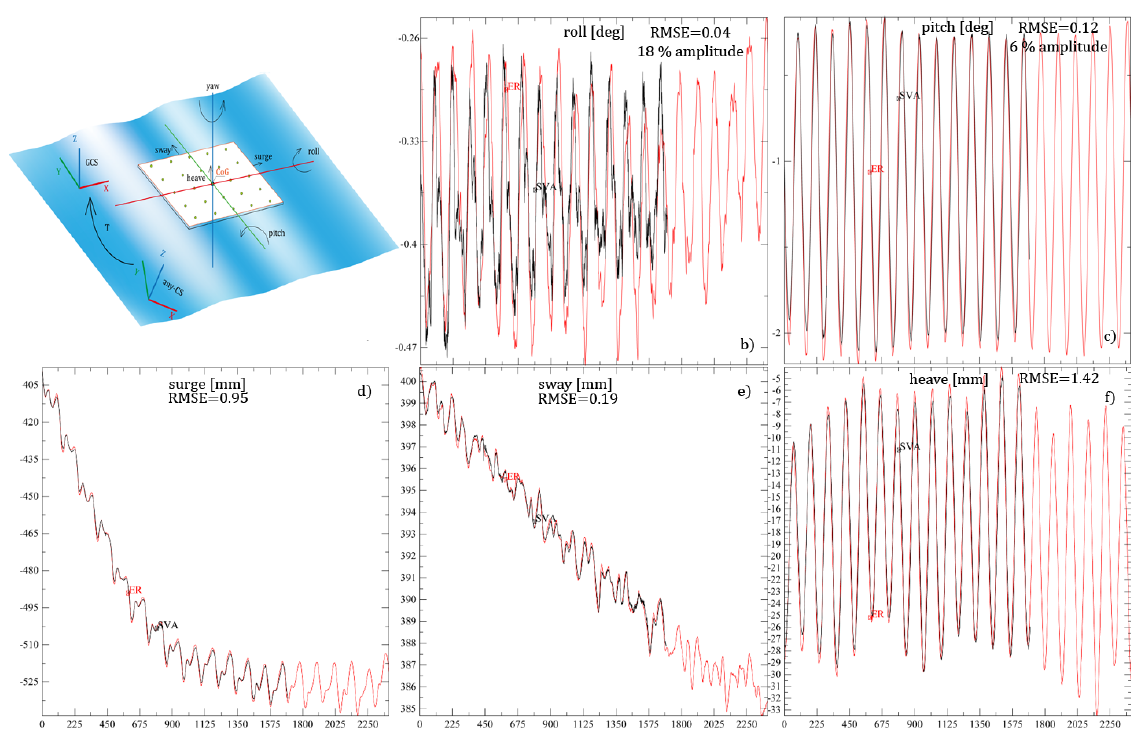
Figure 5: Evaluation of the results with static camera system; in red low-cost system, in black motion capture system a) definition of ship motions, b-c) rotational part, d-f) translational part of the motion.